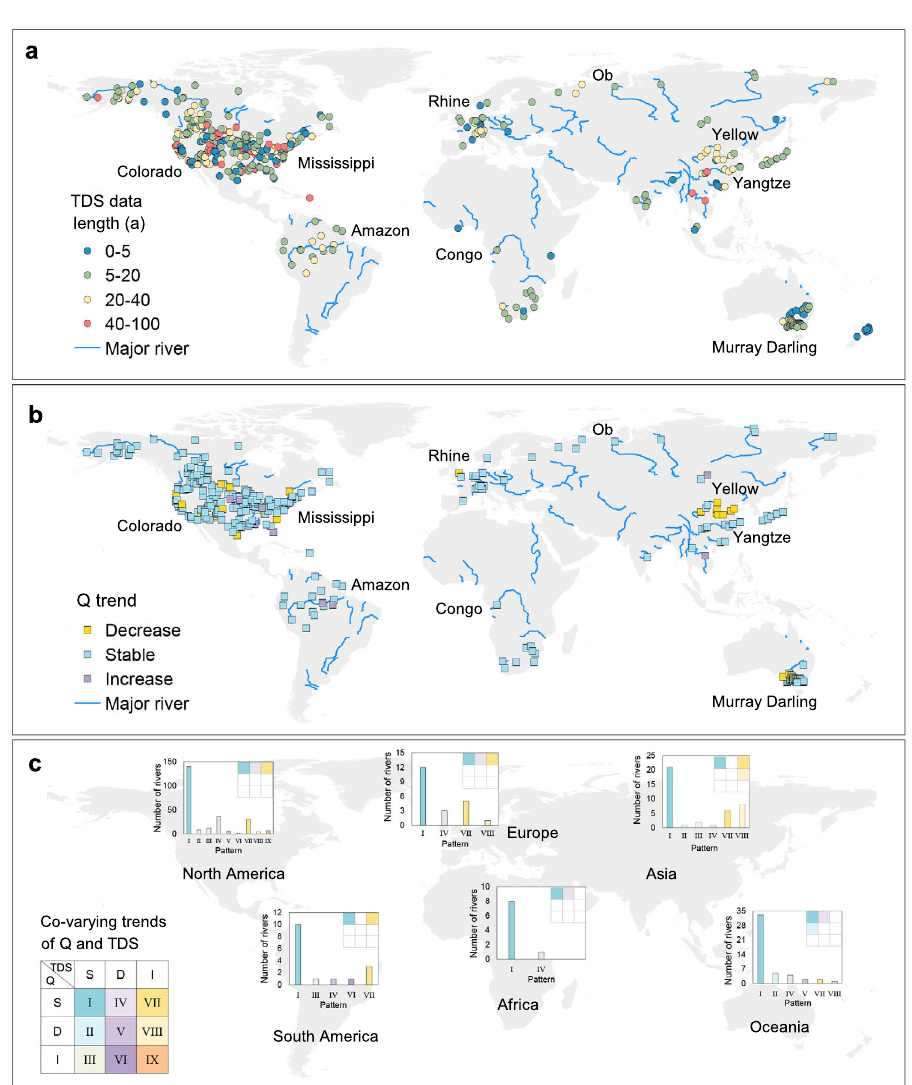
Fig. 1 Global distribution of trends in total dissolved solids (TDS) and water discharge ( Q ). a Global distribution of TDS data length in 149 world ’ s large rivers. b Trends in Q for 600 hydrologic stations. c Number of rivers with different patterns of co-varying trends in Q and TDS in each of six continents. The insert Sudoku table and histograms display the three (or two) dominant patterns for each continent. All trends are signi fi cant at the 0.05 signi fi cance